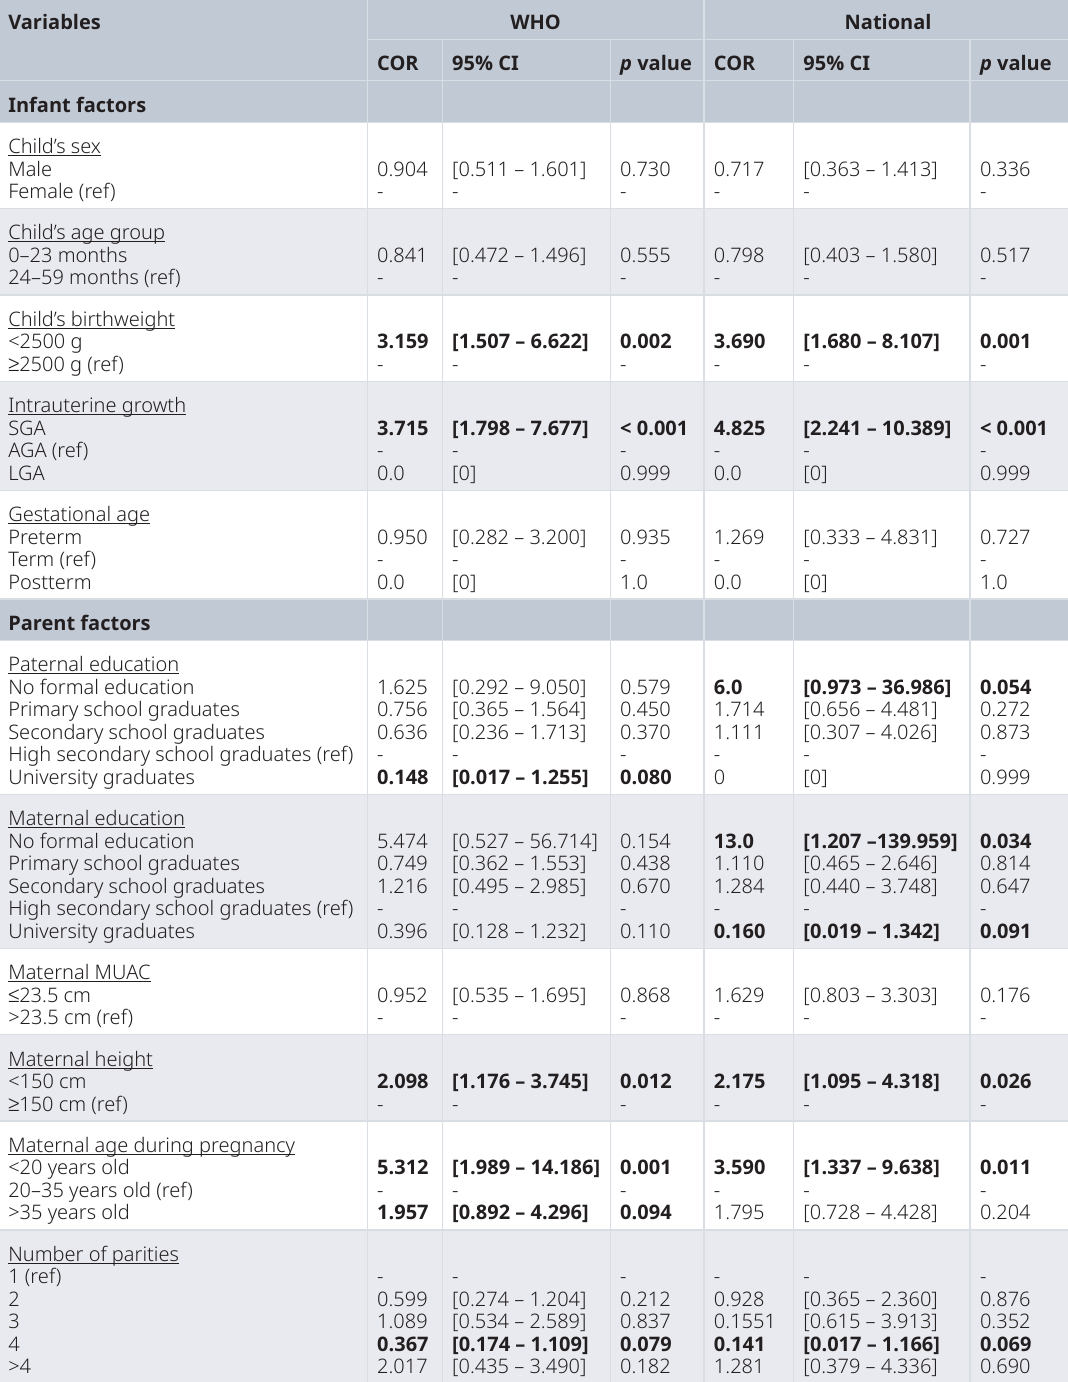
Table 5. Univariate analysis of determinants for underweight among children aged 0–59 months in Musi Sub-district.